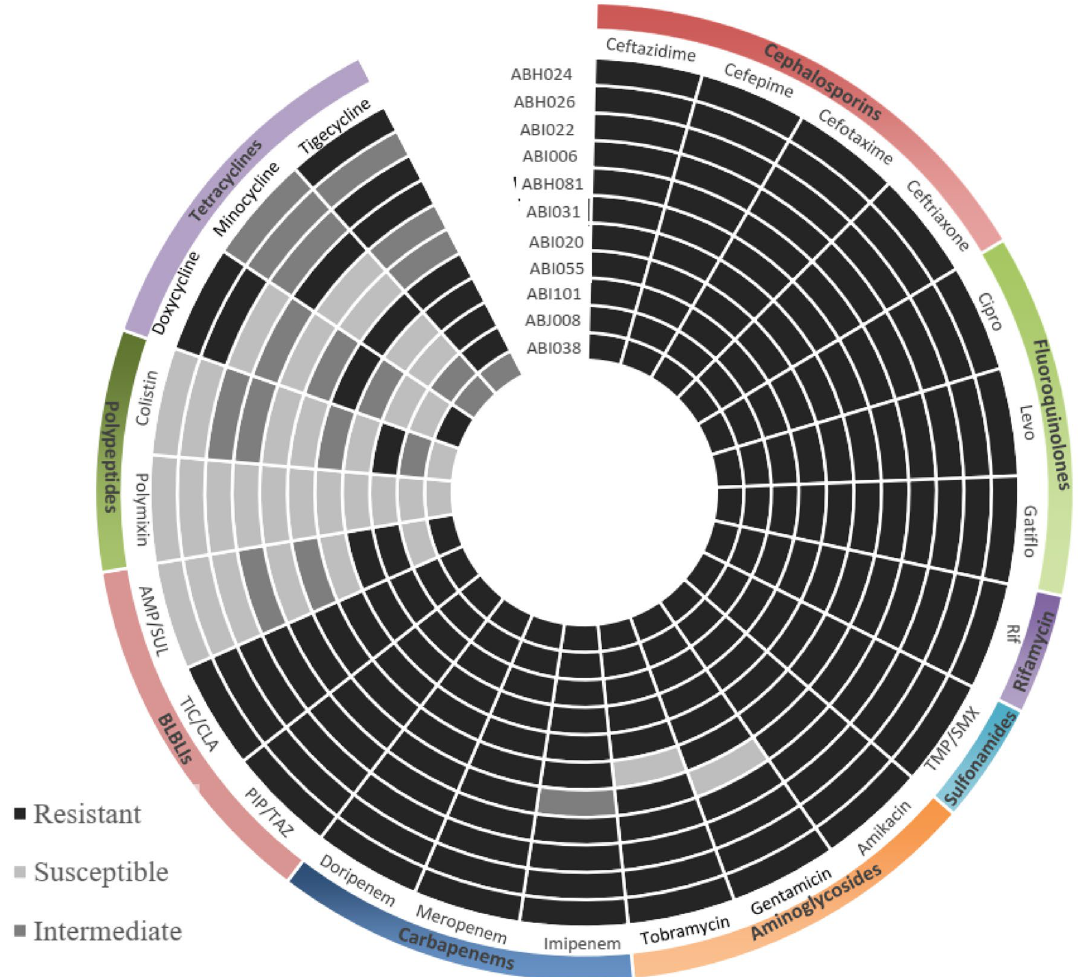
Figure 1. Drug resistance pattern of clinical isolates of A. baumannii . Drug resistance of eleven clinical isolates of A. baumannii is presented. Among these multi-drug resistance strains, ABI022 and ABI038 were selected for animal studies based on adherence assays to biotic and abiotic surfaces. Cipro ciprofloxacin, Levo Levofloxacin, Rif Rifampicin, TMP/SMX Trimethoprim/sulfamethoxazole, BLBLIs β-lactam-β-lactamase inhibitor antibiotics, PIP/TAZ Piperacillin/tazobactam, TIC/CLA Ticarcillin/clavulanate, AMP/SUL Antigen‑specific IgG responses generated by CsuA/B‑FimA‑BauA‑HemTR combination. To evaluate the immunogenicity of recombinant proteins, BALB/c mice had divided into two groups which subcutaneously were immunized three times with the combination of four proteins (immunized group) or PBS (control group) at a 14-day interval (Fig. 4). Mouse sera (n = 4) were collected on day 42, 2 weeks after the last immunization, to evaluate antigen-specific antibody responses using the ELISA test. The result showed that anti-pilus and anti-receptor total IgG levels elevated so high that the absorbance value (OD 450) was observed even at the highest dilution (1:256,000) (Fig. 5A). Antibody titer levels in the immune group were significantly higher than in the control ( p < 0.001). Notably, the level of IgG raised to pilus proteins was similar to the level of anti-iron receptor antibody, and no significant difference was noted between them (Fig. 5B).